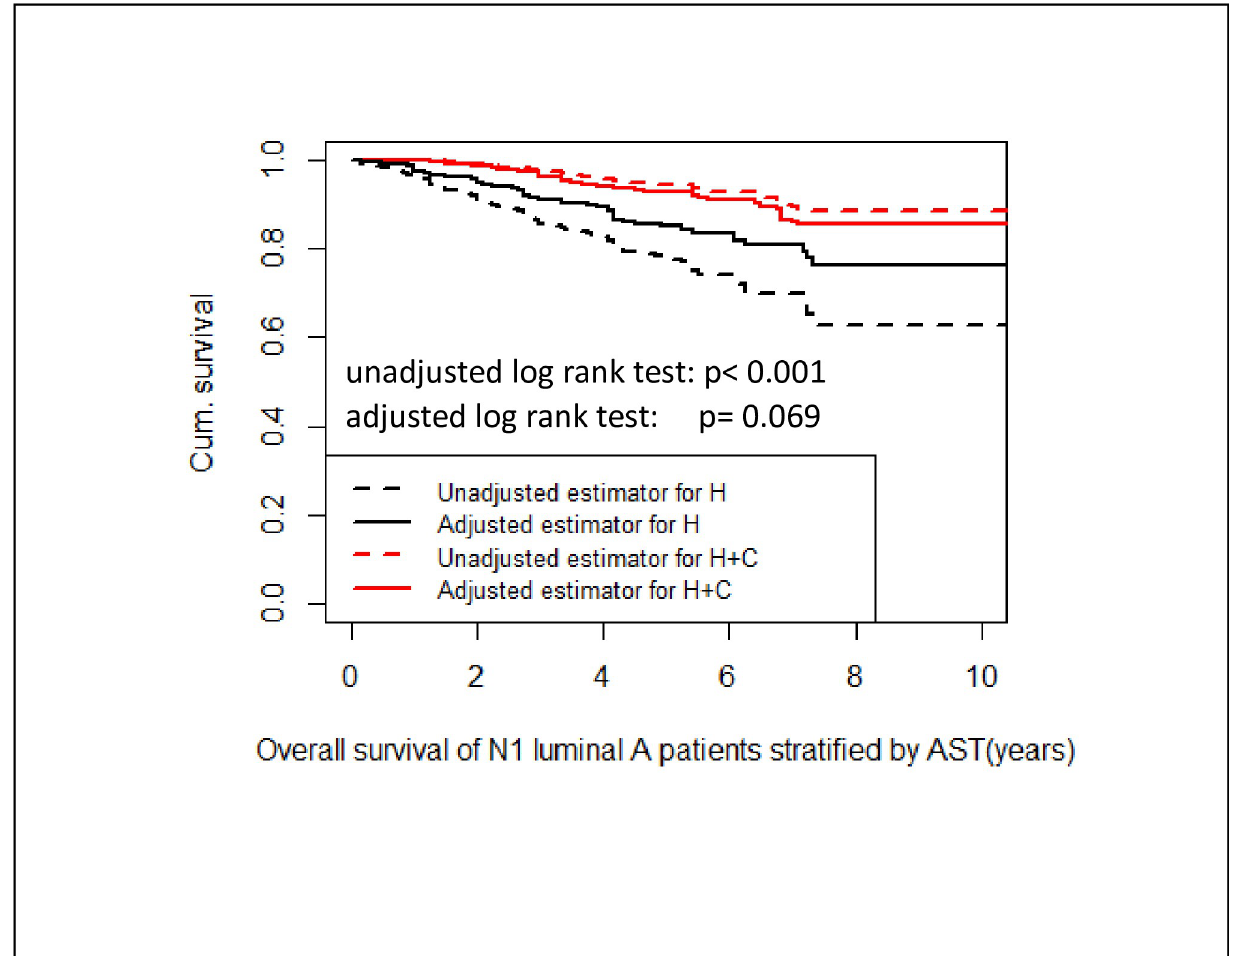
Fig 5. Adjusted survival. Unadjusted and adjusted Kaplan-Meier curves stratified by nodal positive luminal A patients with endocrine therapy and patients with endocrine and chemotherapy. The adjusted log rank test shows no significant difference in OS between both groups (p = 0.069).